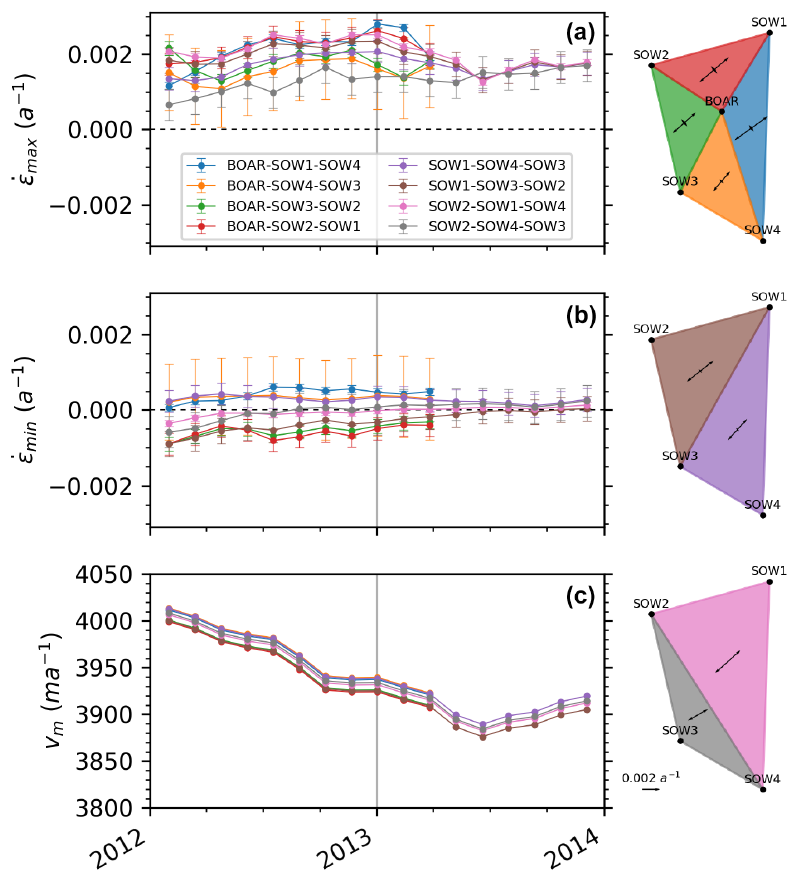
Figure 6. Horizontal strain rates over 42-day periods for eight different triangular sections within the GPS array. (a) First principal strain rate, positive for extension. Error bars calculated for uncorrelated GPS position error of 1cm. (b) Second principal strain rate. (c) Velocity magnitude. Diagrams in right column show color-coded triangular sections, with ∼ 2-year mean of principal strain rates plotted at